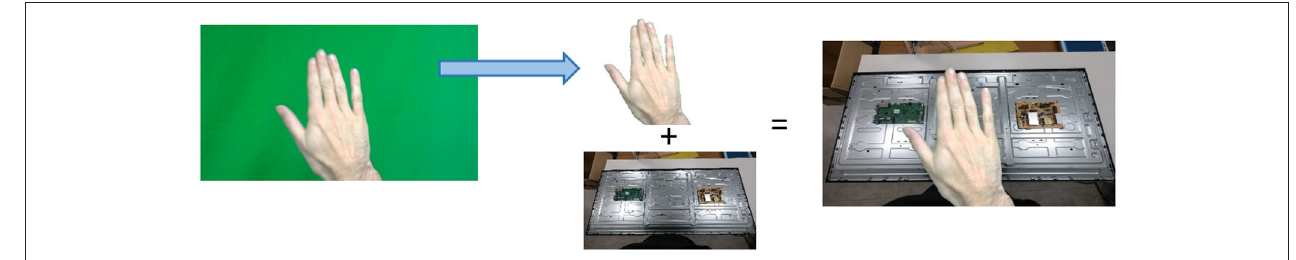
FIGURE 6 | Preparation process of the dataset used for transfer learning.